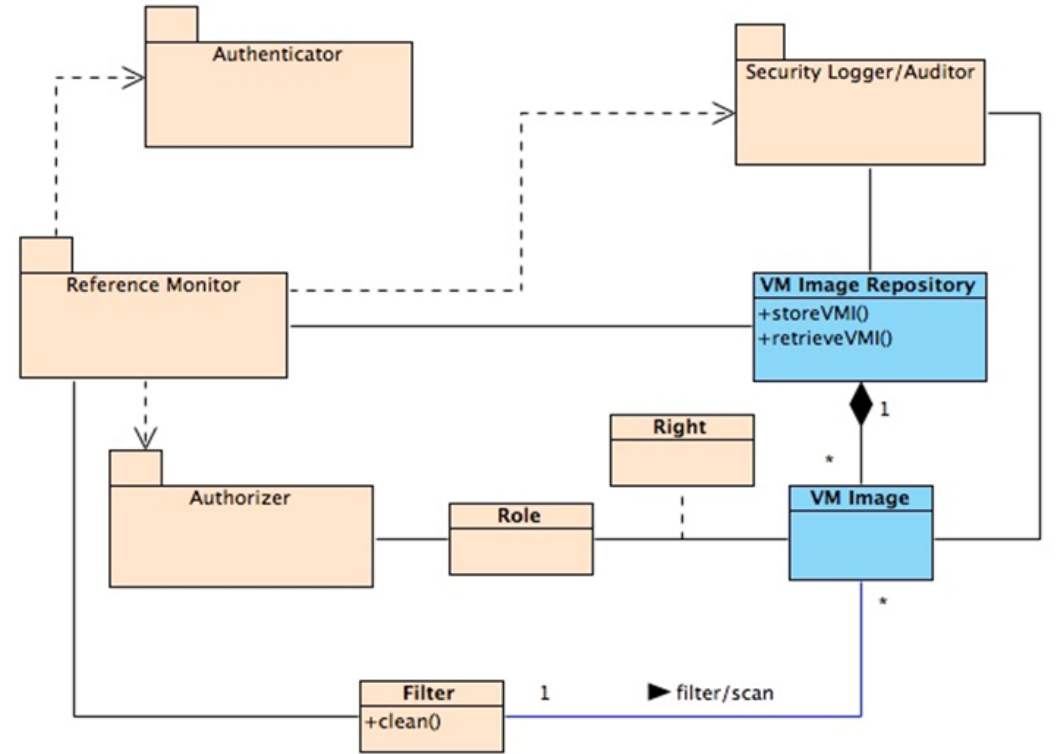
Figure 2. Secure Virtual Machine Image (VMI) Repository System.